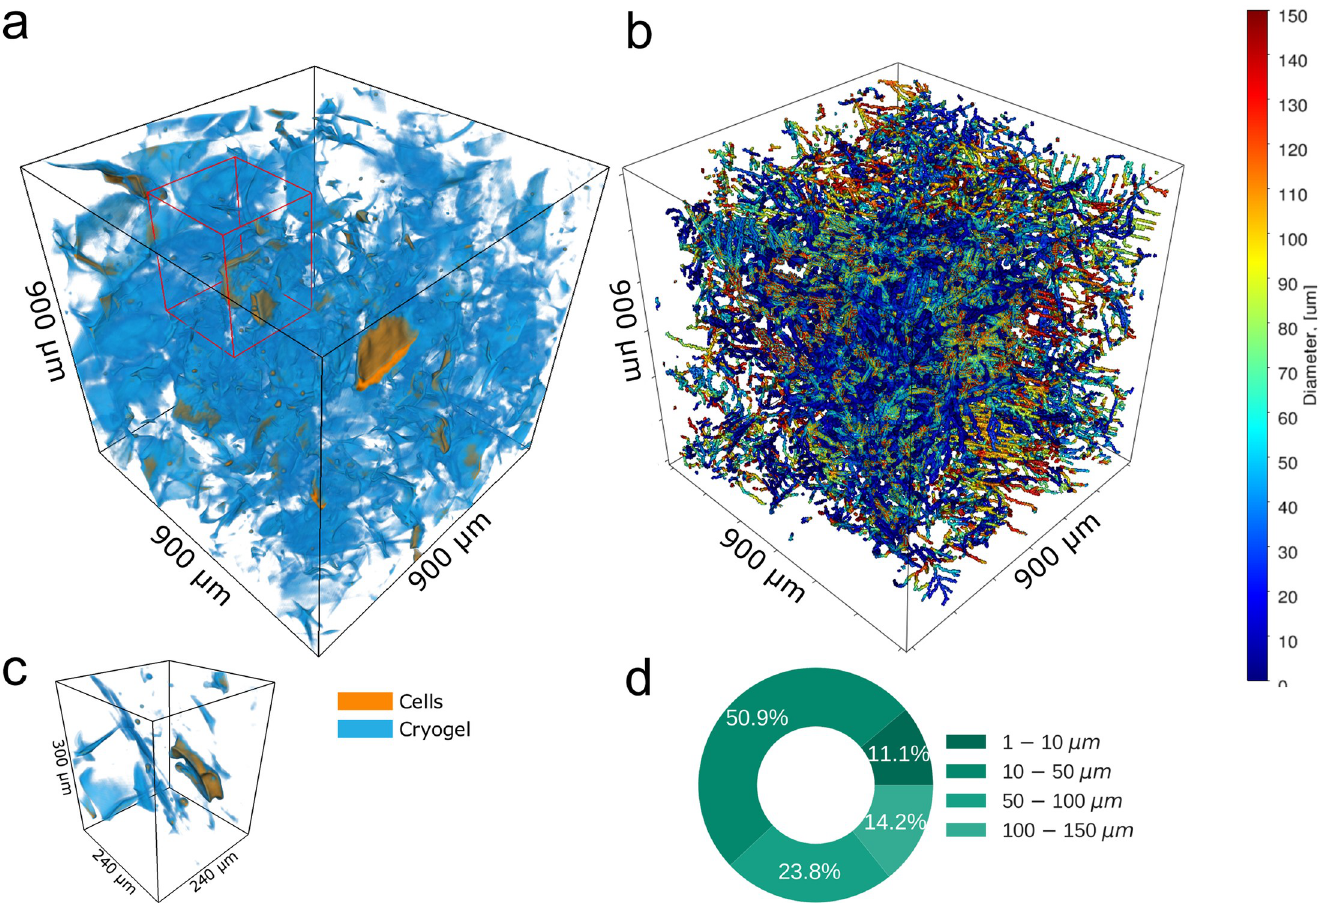
Fig 6. The 3D visualization of cryogel scaffolds with pancreatic cells (a) and diameter estimation of the scaffolds walls (b). The ROI enclosing a single pancreatic cell (c) and the pie chart (d) representing the amount of thin and thick scaffold walls.